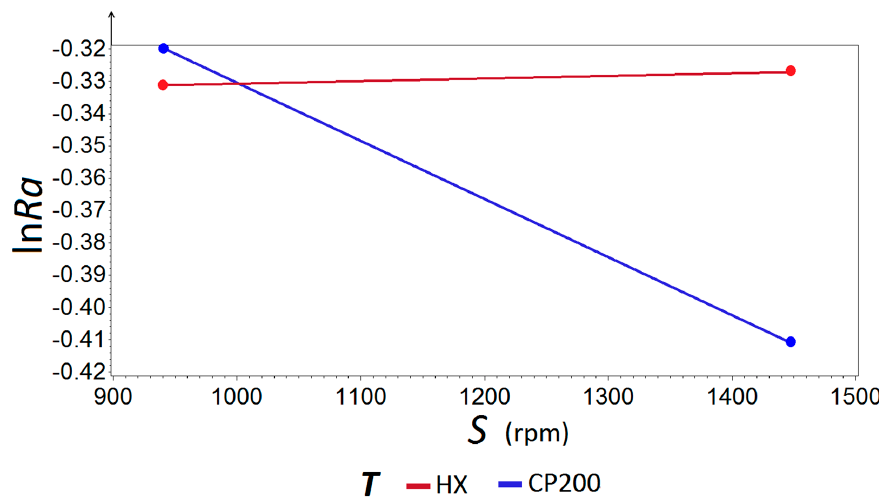
Figure 11. Interaction between the type of tool and the spindle speed for ln Ra.